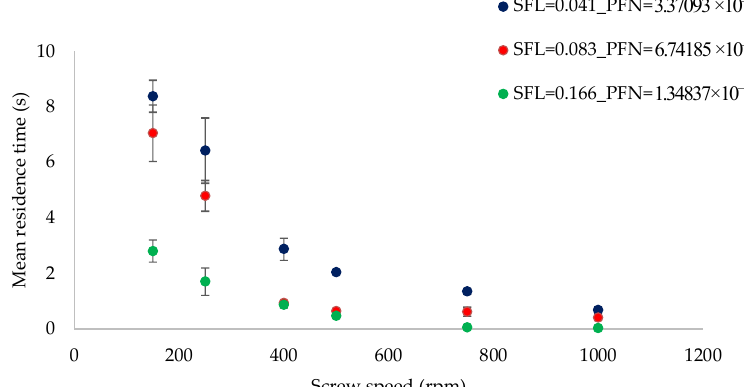
Figure 15. Mean residence time of microcrystalline cellulose (MCC) at different SFL–PFN at varying screw speed (L/S 1).